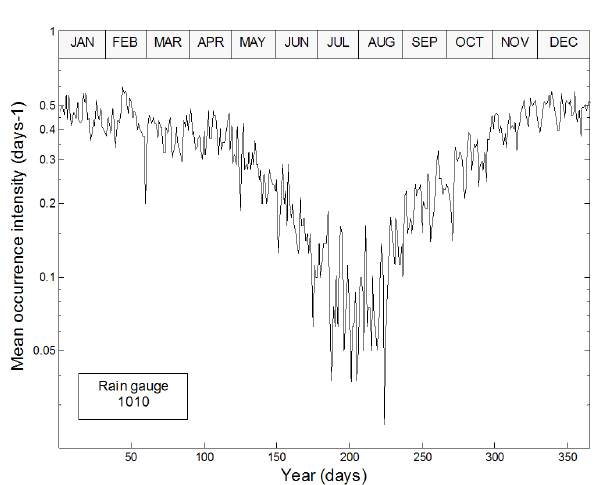
Fig. 1. Example of time variability of the intensity function of daily rainfall